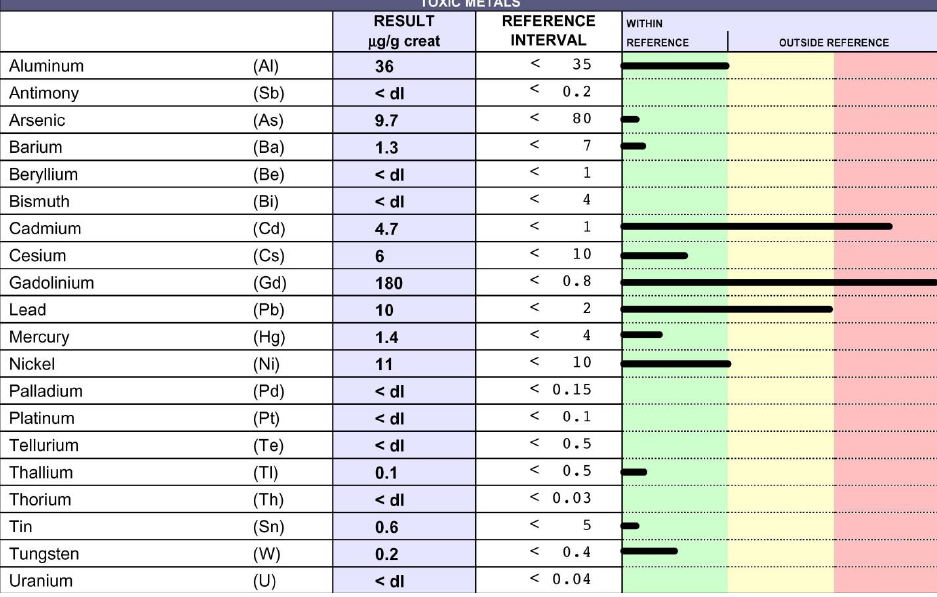
Figure 4. TM levels decreased after EDTA therapy: The presence of TMs in the urine samples of IM following 9 months of therapy with EDTA was evaluated using inductively coupled plasma mass